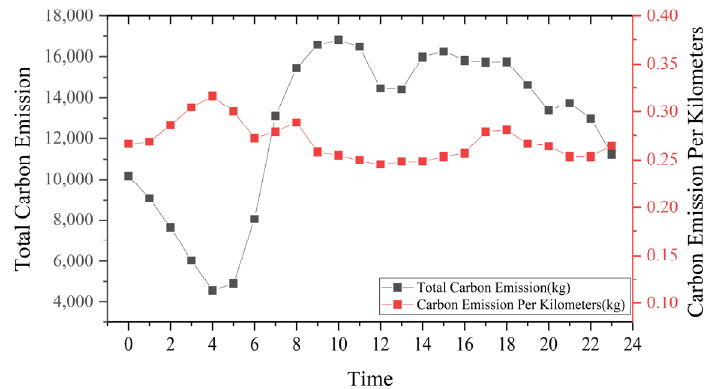
Figure 8. Carbon emissions and average per kilometer.